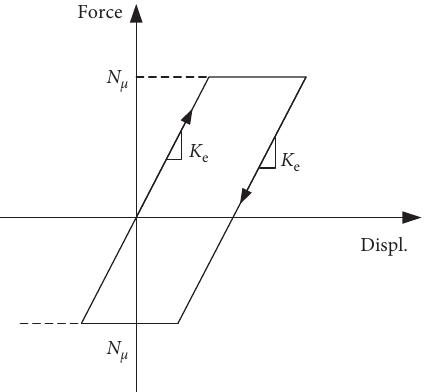
Figure 7: Analytical model of the sliding of elastomeric